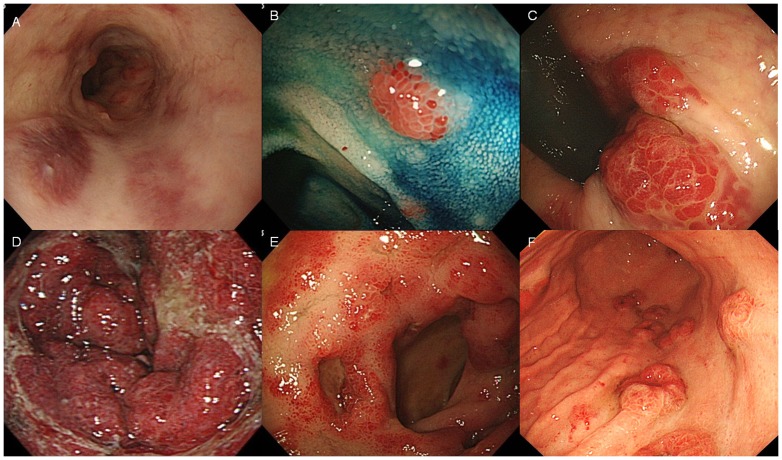
Gastrointestinal Kaposi's sarcoma on endoscopy.
A) Dark-reddish flat lesions in the esophagus. B) Chromoendoscopy with indigo carmine dye showed a polypoid nodule in the terminal ileum. C). Submucosal lesions in the rectum. D) Bulky tumor surrounding the antrum of the stomach and causing pyloric stenosis. E) Circumferential flat lesions with ulceration in the duodenum. F) Multiple nodules in the stomach.